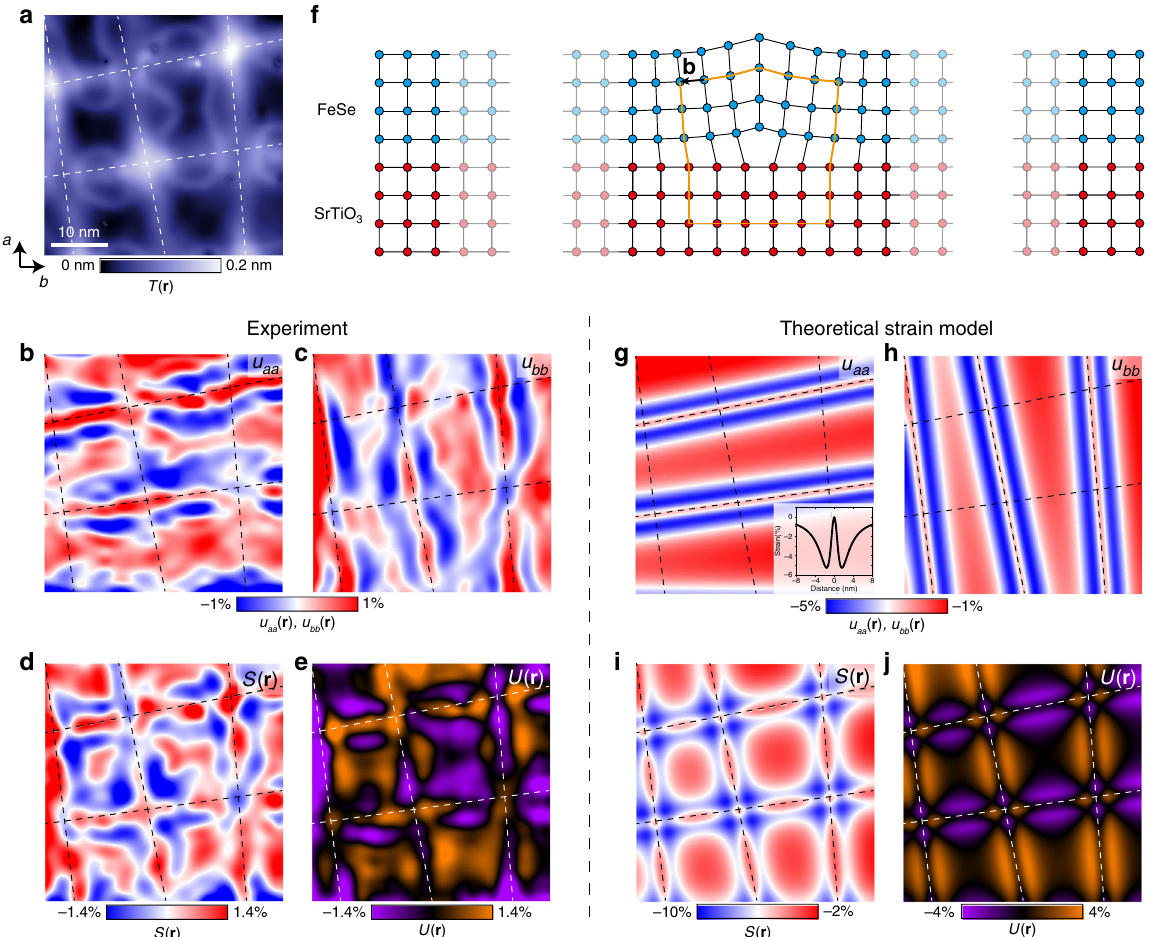
Fig. 3 Strain analysis and comparison between experimental and theoretically predicted strain maps. a Atomically resolved STM topograph, where a -axis and b -axis denote the nearest-neighbor Fe – Fe directions. Dashed lines are guides to the eye for the structural modulations. Strain tensor components b u aa r ð Þ and c u bb r ð Þ derived from a . d Symmetric strain map S r ð Þ (cid:2) u aa r ð Þ þ u bb r ð Þ . e Antisymmetric strain map U r ð Þ (cid:2) u aa r ð Þ (cid:3) u bb r ð Þ . f Schematic of an edge dislocation. Vector b denotes the Burgers vector. Blue (red) circles schematically represent the FeSe (SrTiO 3 ) lattice. Theoretical maps of g u aa r ð Þ , h u bb r ð Þ , i S r ð Þ and j U r ð Þ . The inset in g shows the strain created by a single dislocation line as a function of the distance from it. In our model described in detail in Supplementary Note 7, Burgers vector b is set to be 0.53 nm, which is the Se – Se distance along [110] direction on the top or the bottom of an FeSe monolayer (ML), and the thickness d is set to be 1.6 nm, or 3 ML of FeSe. STM setup condition: a I set = 110 pA, V sample = − 100